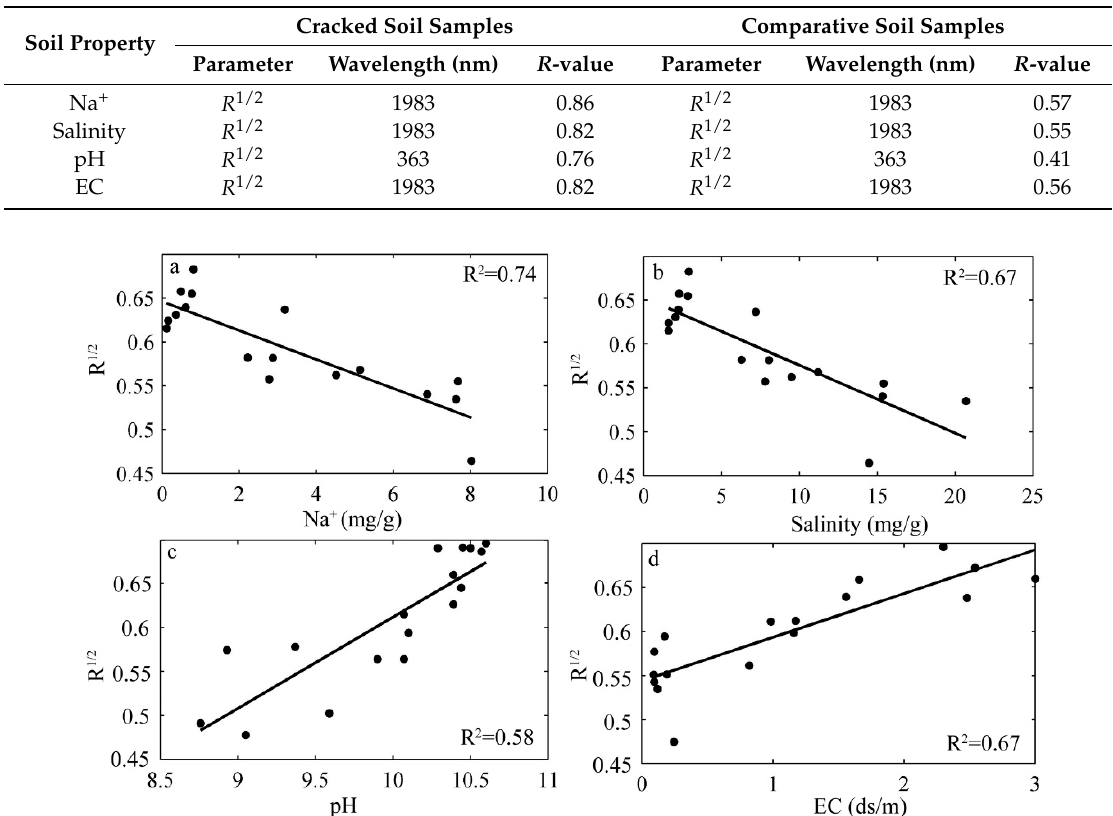
Figure 5. Regression models for soil properties of the cracked soil samples.